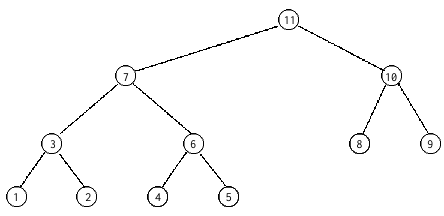
Fig. 3: A binary tree with 11 internal nodes, that are labelled by postorder traversal. Node 5 has one descendant and four